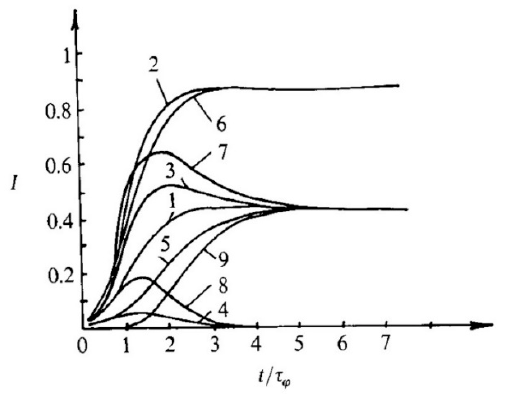
Figure 2. Electrooptical response of the surface stabilized FLC (SSFLC) cell for different phase factors k = 1 to 9, the phase factor k is defined as d Δ n/ λ = k/4 [20].